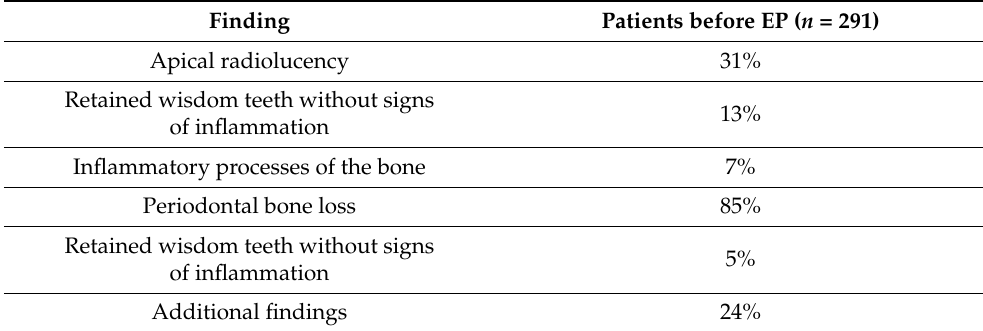
Table 4. Radiological findings of patients before endoprosthesis (EP).